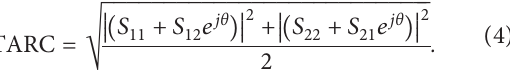
Figure 15 represents the measured and simulated TARC of the proposed MIMO antenna. As can be seen from this figure, it is better than − 10 dB at the operating band.